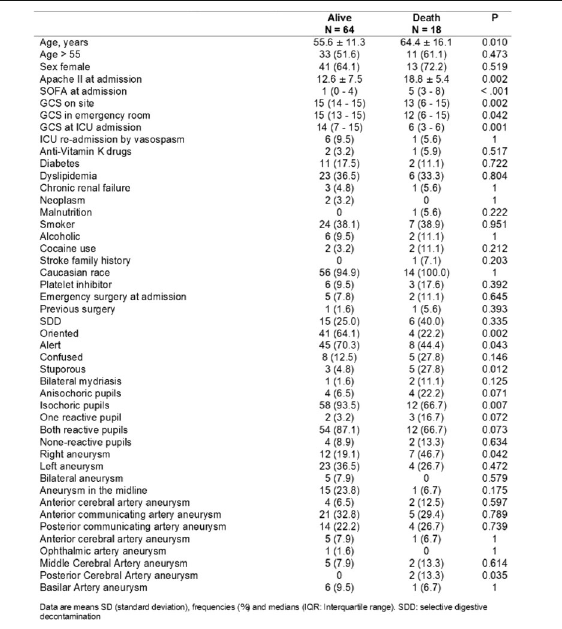
Table 1b (abstract 001123). Characteristics of the patients according survival/death